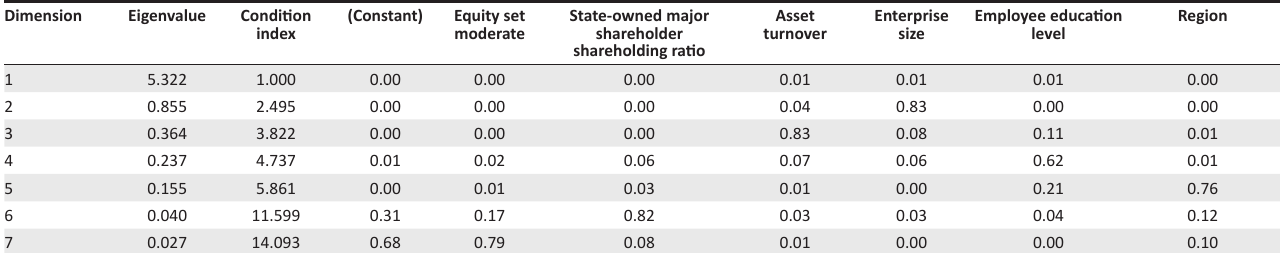
TABLE 2: Multicollinearity diagnosis table.